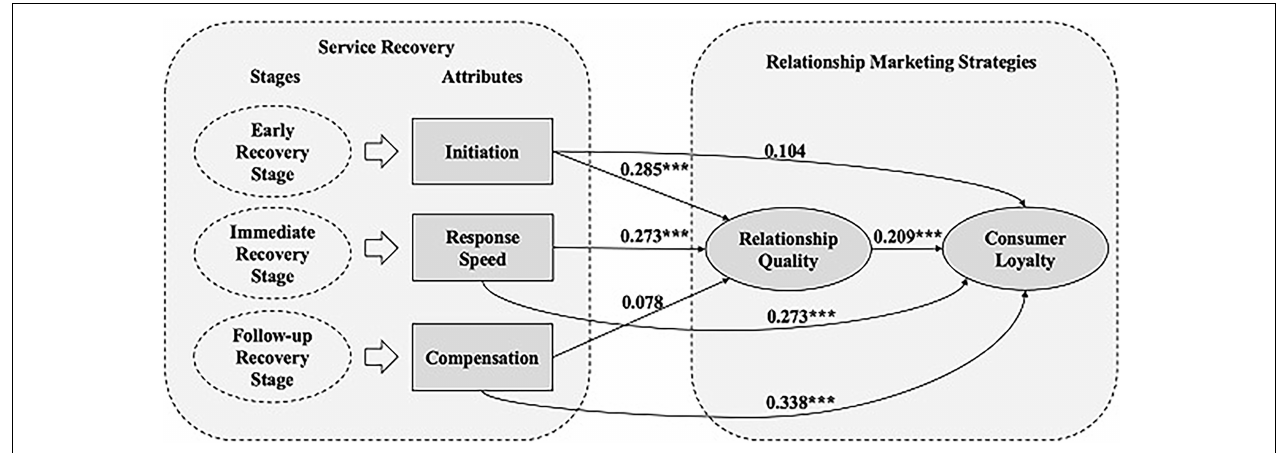
FIGURE 3 | Results of structural modeling. ∗ p < 0.05, ∗∗ p < 0.01, and ∗∗∗ p < 0.001. n = 301, χ 2 = 589.863, df = 329, CFI = 0.981, GFI = 0.884, NFI = 0.096, and RMSEA = 0.0452.